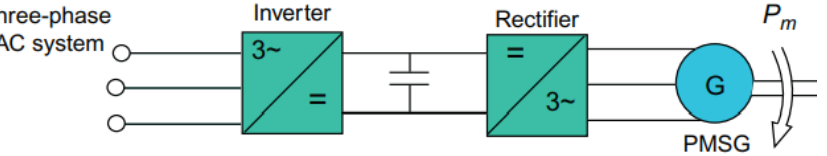
Figure 3. Electrical components of WECS.